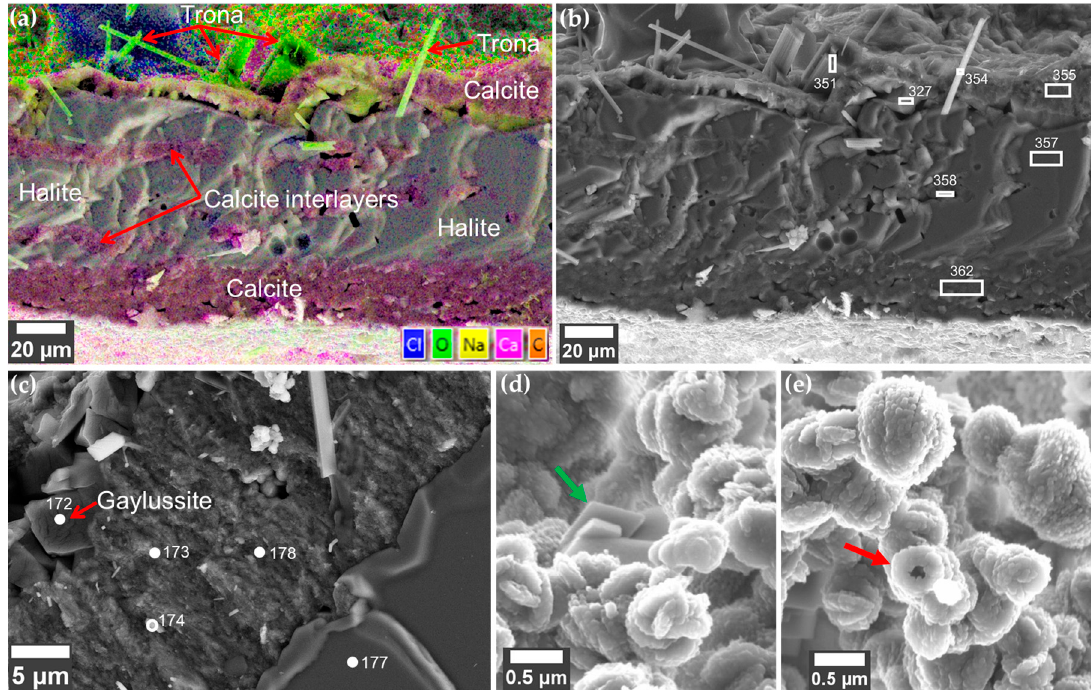
Figure 5. SEM micrographs of calcium vesicles synthesized by adding drops of calcium chloride solution in Magadi water. ( a ) EDX map of the membrane cross-section containing bilayer of calcite, halite core, interlayered calcite and trona on the external surface; ( b ) SEM micrograph of the panel ( a ) with points where EDX analysis was performed (see Figure S5); ( c ) cross-section of the membrane showing gaylussite crystals; ( d ) rhombohedral calcite (green arrow); ( e ) hollow vaterite sphere (red arrow) on the exterior of the membrane.